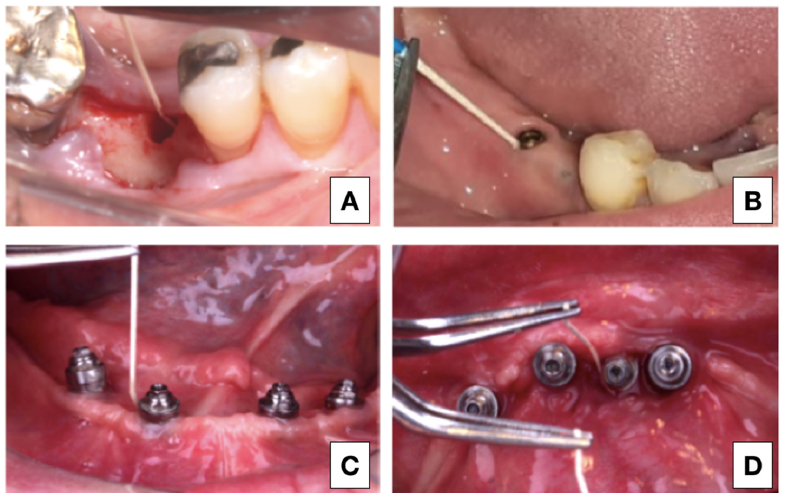
Figure 1. ( A ) GROUP 1 ( n = 10): Sample collection from the surgical alveolus, previously implant placement. ( B ) GROUP 2 ( n = 10): PICF collection 15 days after implant exposure. ( C ) GROUP 3 ( n = 8): PICF collected from healthy peri-implant tissues after prostheses removal. ( D ) GROUP 4 ( n = 18): samples from PICF in mucositis affected peri-implant tissues.